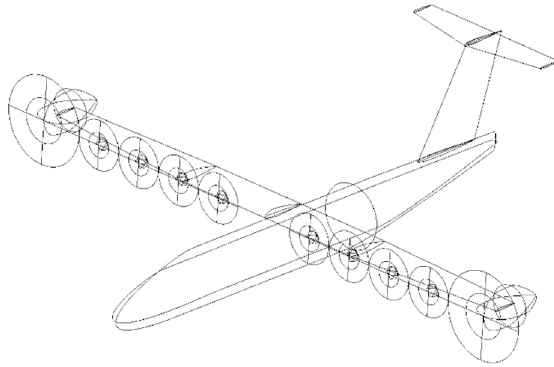
Figure 10. CAD representation of the airframe.